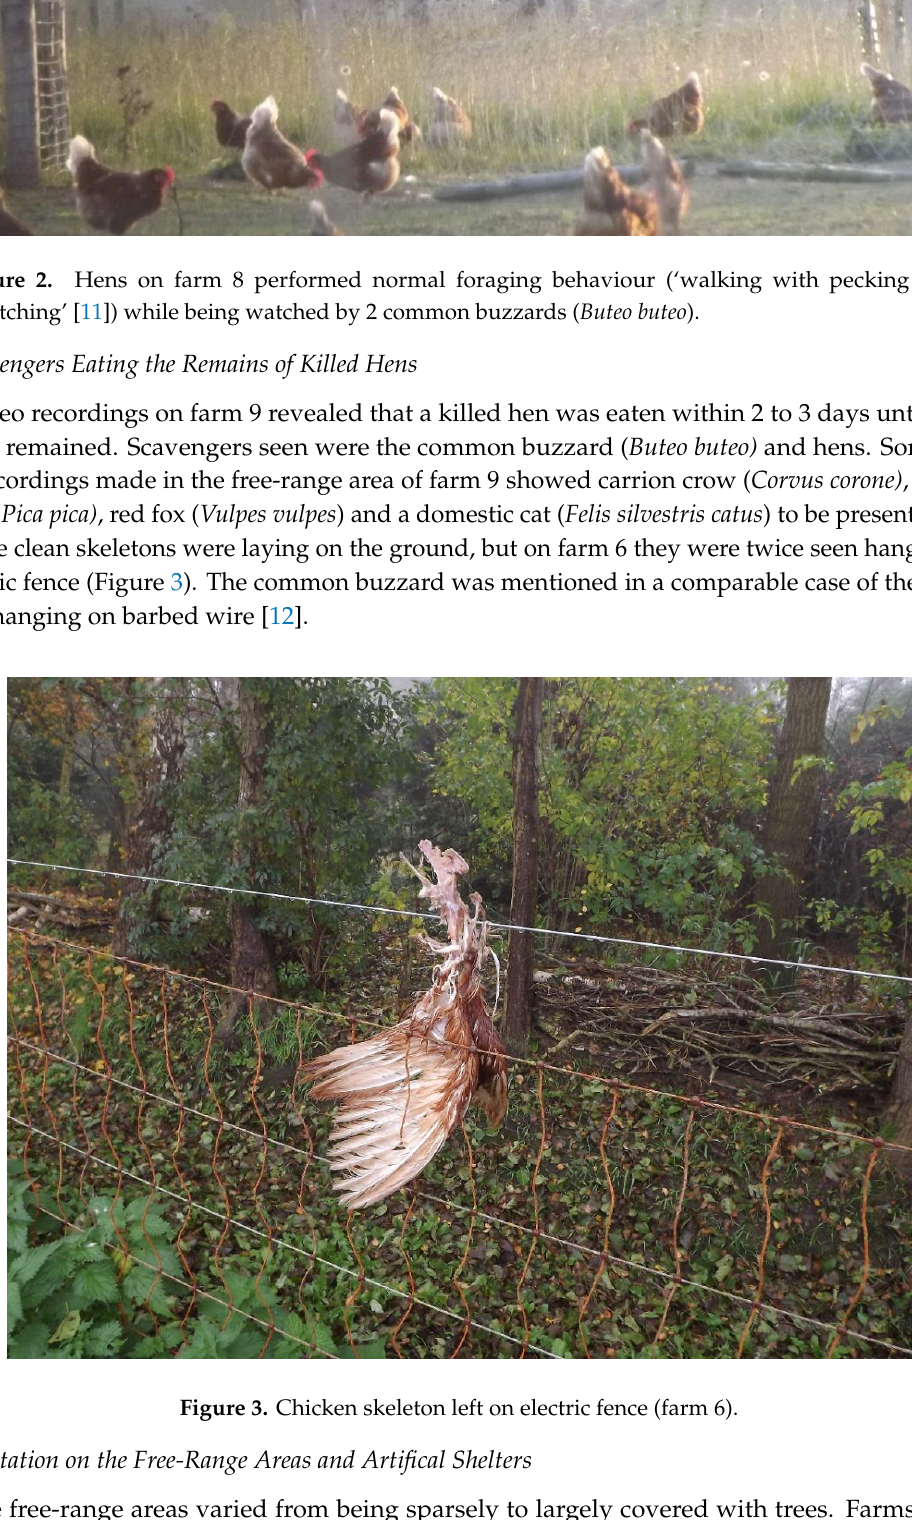
10 of 18 Figure 1. Northern goshawk ( Accipiter gentiles ) during attack 11. 3.3. Features and Behaviour of Attacked Hens and Bystander Hens None of the hens attacked in the 16 described attacks were visibly ill, impaired, weakened or already dead. In other words: birds of prey attacked hens that were considered to be healthy (attacks 1–16). Sometimes, the initial response of hens was to drop down (attacks 4–8, 10), but most hens tried to escape or fought back (attacks 4–7, 10). Bystander hens ran away (attack 8) but were also seen trying to chase away the bird of prey (attacks 14, 15). In several instances, while the bird of prey was eating from its prey, other hens came closer and closer (attacks 11–14), sometimes to less than one